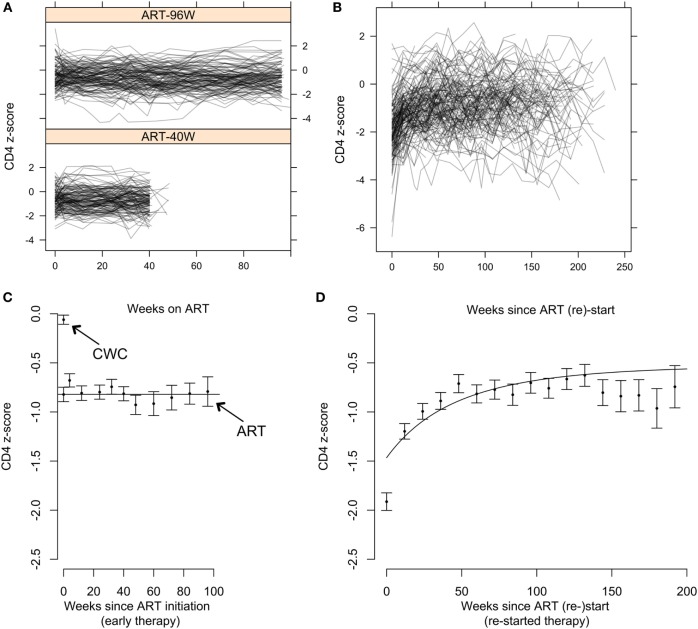
CD4 T-cell dynamics in children on early antiretroviral therapy (ART) and on continuous ART restarted after treatment interruption. (A) Individual CD4 z-score trajectories for children on early ART for 96 weeks (ART-96W) and 40 weeks (ART-40W). (B) Individual CD4 z-score trajectories on continuous ART restarted after treatment interruption. (C) Means and SEs in the mean (±SEM) of combined ART-96W and ART-40W CD4 z-scores for each sampling time on early treatment. The continuous straight line indicates the population-average model fit for the ART-96W and 40 W samples, showing stability of the z-scores over time. The z-scores in these early-treated children are significantly lower than the mean (±SEM) of the HIV-uninfected Child Wellness Clinic (CWC) cohort. (D) Means and SEM of CD4 z-scores for each sampling time after ART restart, with the population-average model fit. The discrepancy between the beginning of the curve and the first point is likely to be due to redistribution of memory T-cells in response to ART restart and viral suppression.